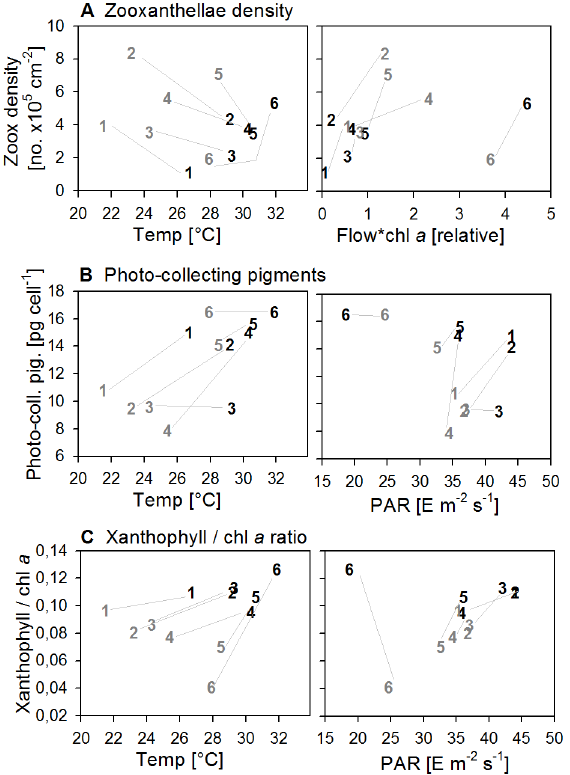
Figure 3. Relationship between environmental parameters and zooxanthellae composition at all sites (1–6) in Sep11 (black) and Mar12 (grey). Data points represent means (standard errors are listed in table S2). The lines connect the two seasons within each site. Light intensity (PAR) in 5 m depth.